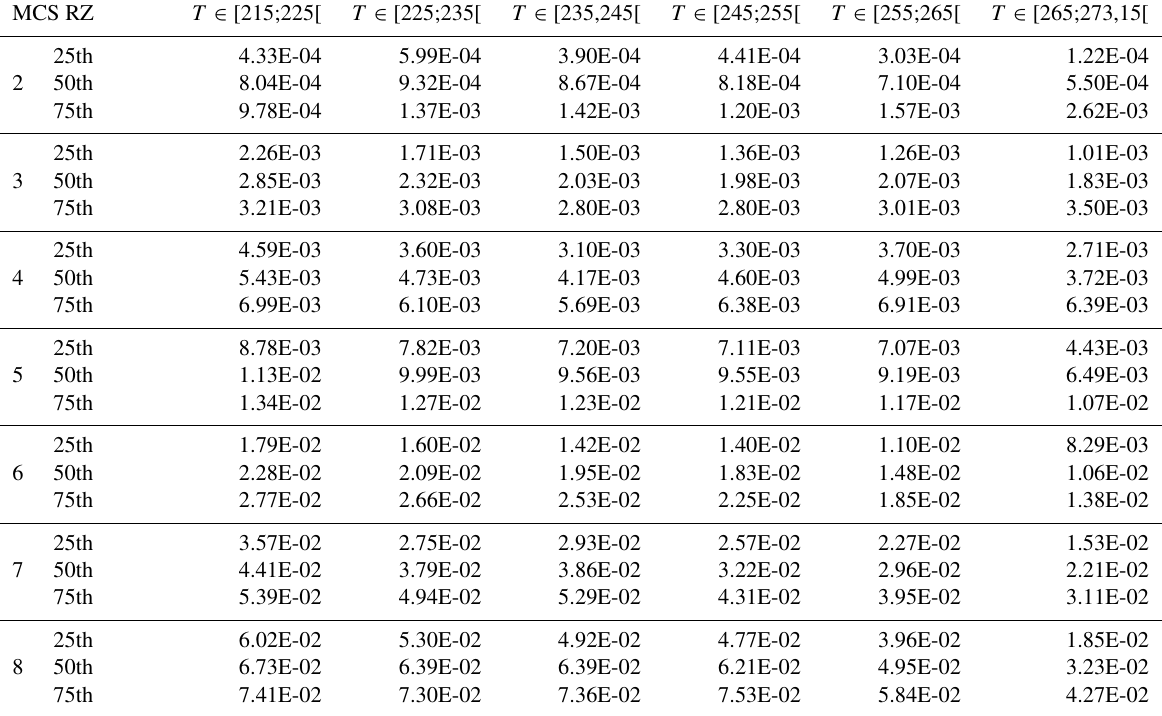
Table C10. The second moment of PSD ( M 2 ) in m − 1 (Fig. 21).